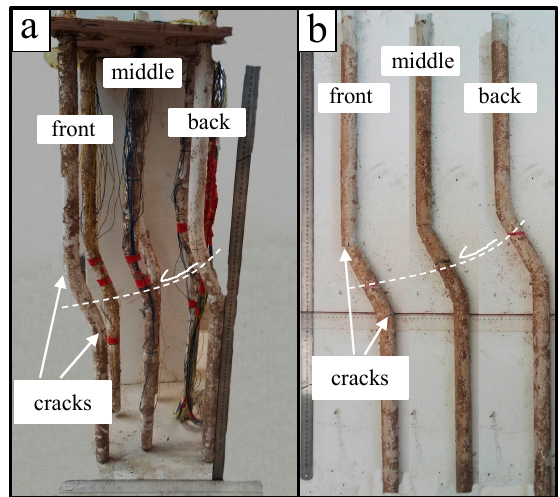
Figure 10 . Failure of micropiles ( a ) static model test; ( b ) shaking table test. In the shaking table test, the landslide had no obvious change after being excited by an El-Centro wave with a peak acceleration of 0.1–0.4 g. After a peak acceleration of 0.6 g, a tension crack AB began to occur in the soil between the front row and the middle row of piles. The crack AB then extended downwards to point C with a width of around 0.8 cm. After the input of an El-Centro wave with a peak acceleration of 0.8 g, the slope started to slide, and the toe of the slope slid forward by 3.5 cm while the top of the slope settled 3.0 cm. At the same time, the crack ABC expanded to point D. The sliding mass